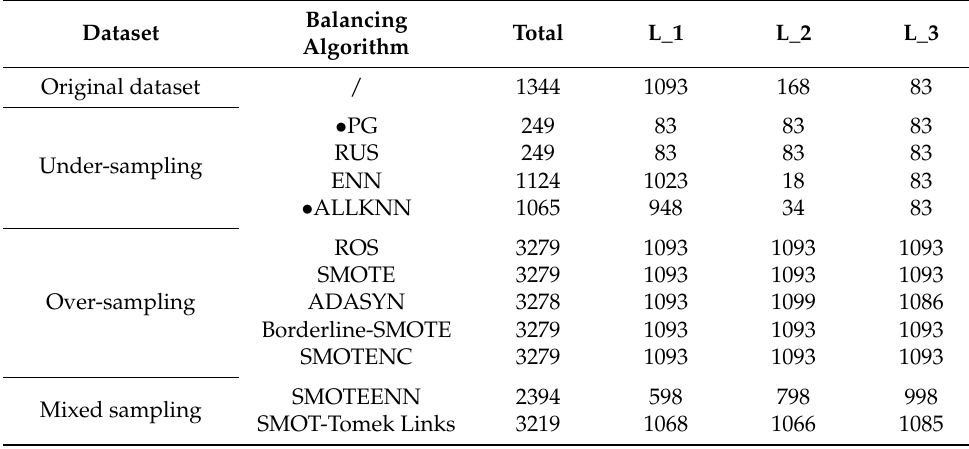
Table 4. Number of sections with different risk levels in the different datasets.